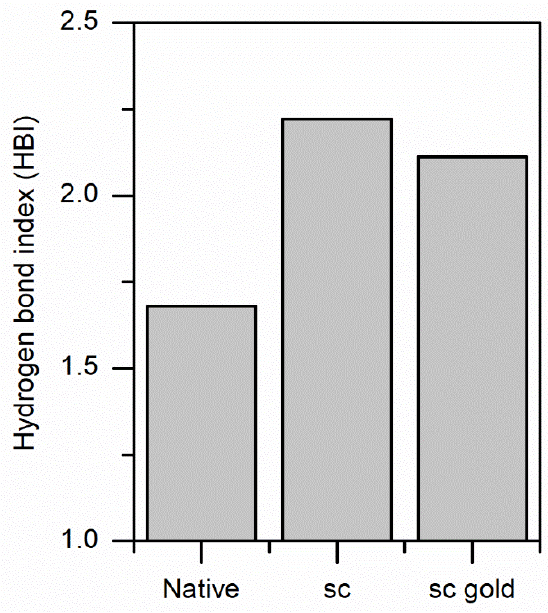
Figure 11. Change in Hydrogen bond index for N-H vibration for native silk, scCO 2 only treated silk, and scCO 2 plus gold NPs impregnated silk.